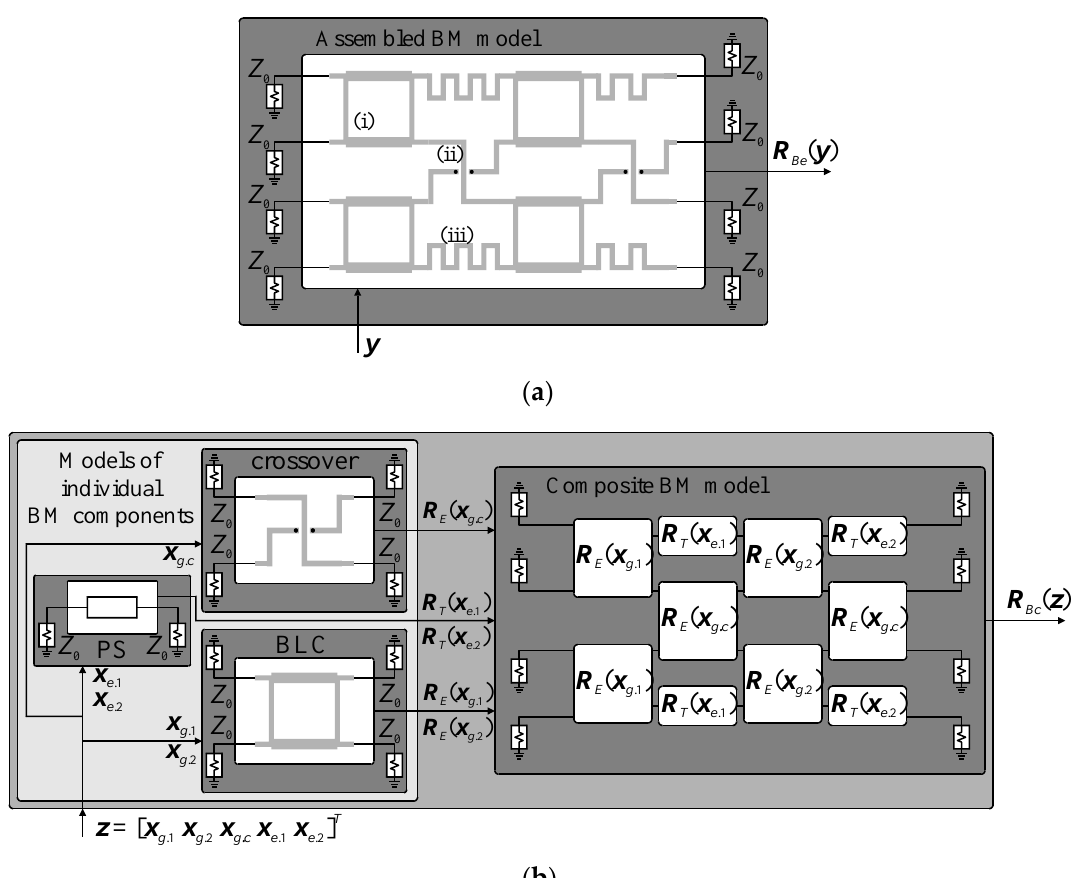
Figure 2. A conceptual illustration of the Butler matrix (BM) models: ( a ) high-fidelity EM model of the assembled matrix where (i)–(iii) denote branch line coupler (BLC), crossover, and phase-shifter, respectively, and ( b ) a composite representation of the structure. Frequency characteristics of the composite BM are obtained from the responses of individual components. In this illustration, R Bc is calculated using EM model responses of crossover (design x g.c ) and BLCs (two designs: x g .1 and x g .2 ), as well as ideal TL model of phase shifters (two designs: x e .1 and x e .2 ).